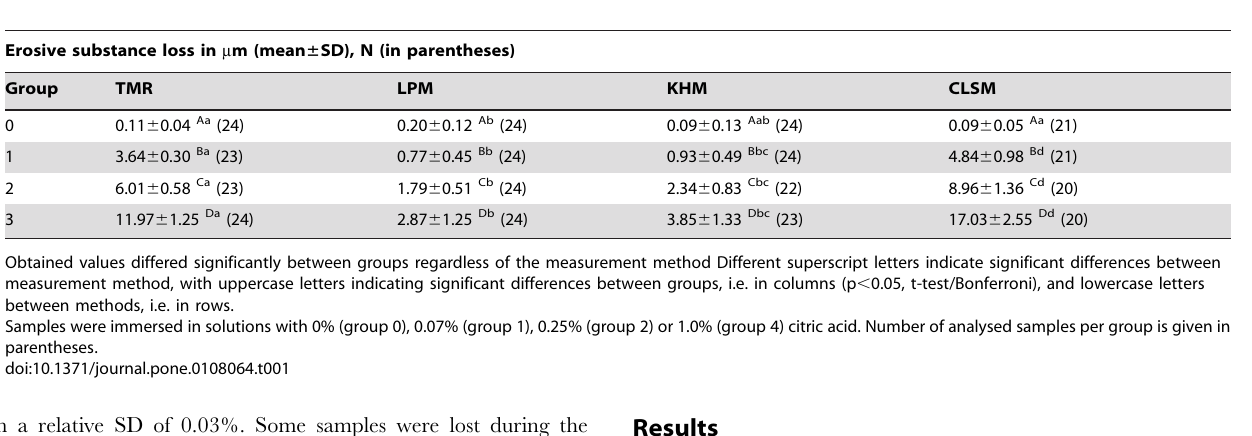
Table 1. Erosive substance loss (in m m) according to different groups as measured using the four different methods.